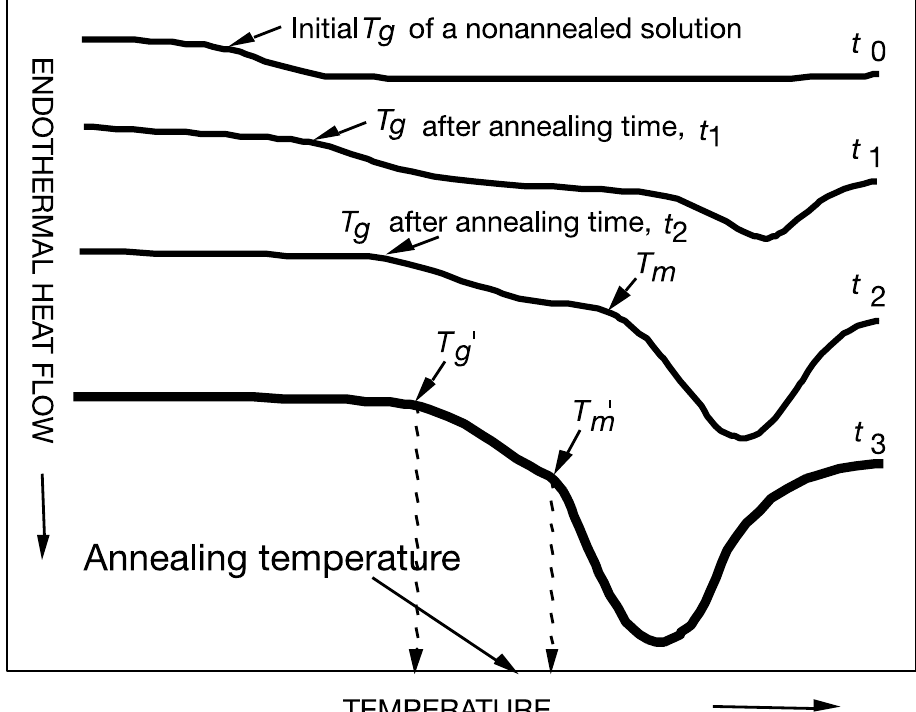
Figure 2. Ice formation in aqueous solutions during isothermal holding using differential scanning calorimetry (DSC) at various temperatures to enhance ice formation (annealing). A maximally freeze-concentrated state can be achieved during isothermal holding slightly below the onset of ice melting temperature, T m ′ . An increase in ice content is shown to increase the freeze concentration and glass transition of the freeze-concentrated solution until maximum ice formation is achieved after annealing for t 3 . Freeze concentration increases during annealing and results in a higher glass transition temperature, T g , as plasticizing water crystallizes into an ice phase.